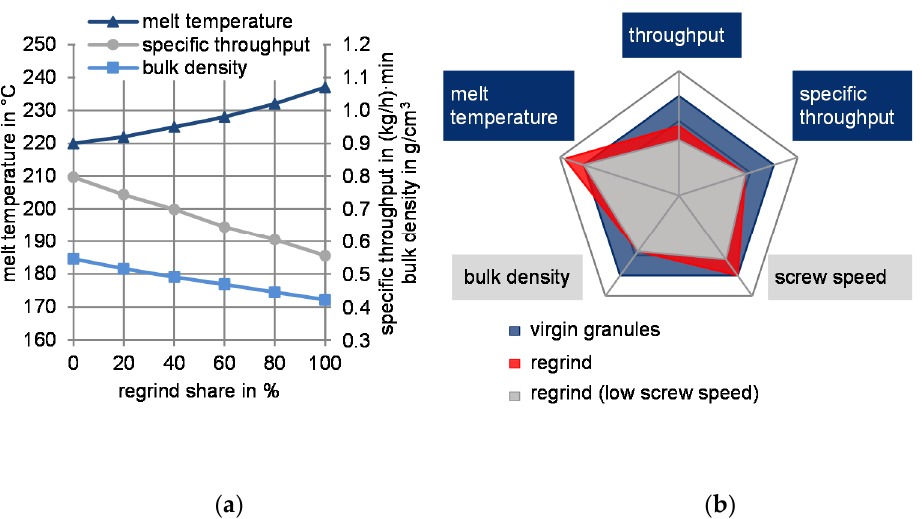
Figure 2. ( a ) Influence of an increased regrind share adapted with permission from [2]. 2021 Michels; ( b ) reduced process window through regrind processing.